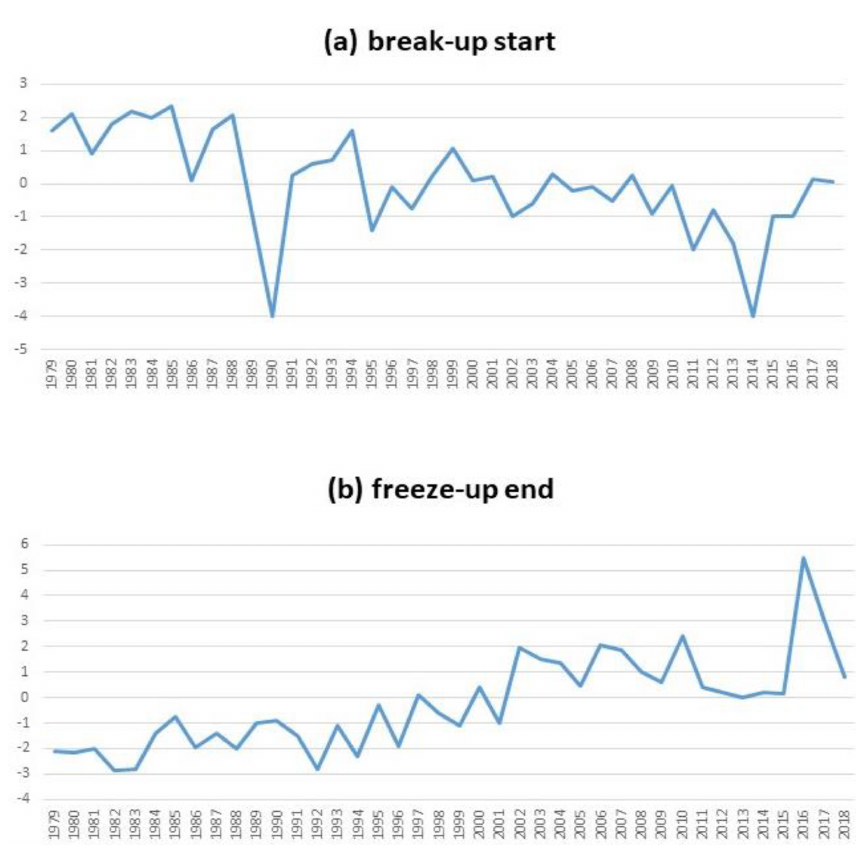
Figure 15. Scores (time series) for Factor 1 of (a) the start of breakup and (b) the end of freeze-up at the 10 local coastal sites.